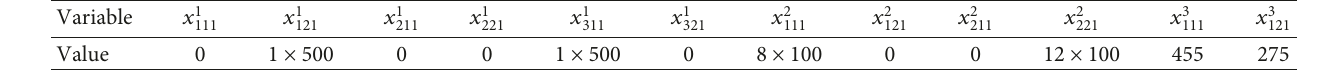
Table 9: The amounts of transported goods to final destinations D1 and